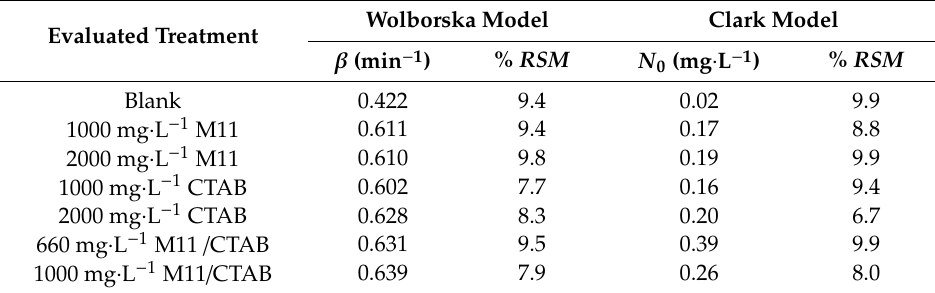
Table 3. Response parameters of Clark [48] and Wolborska [49] models for treatments evaluated varying the concentration of MgO nanoparticles-M11, CTAB, and deionized